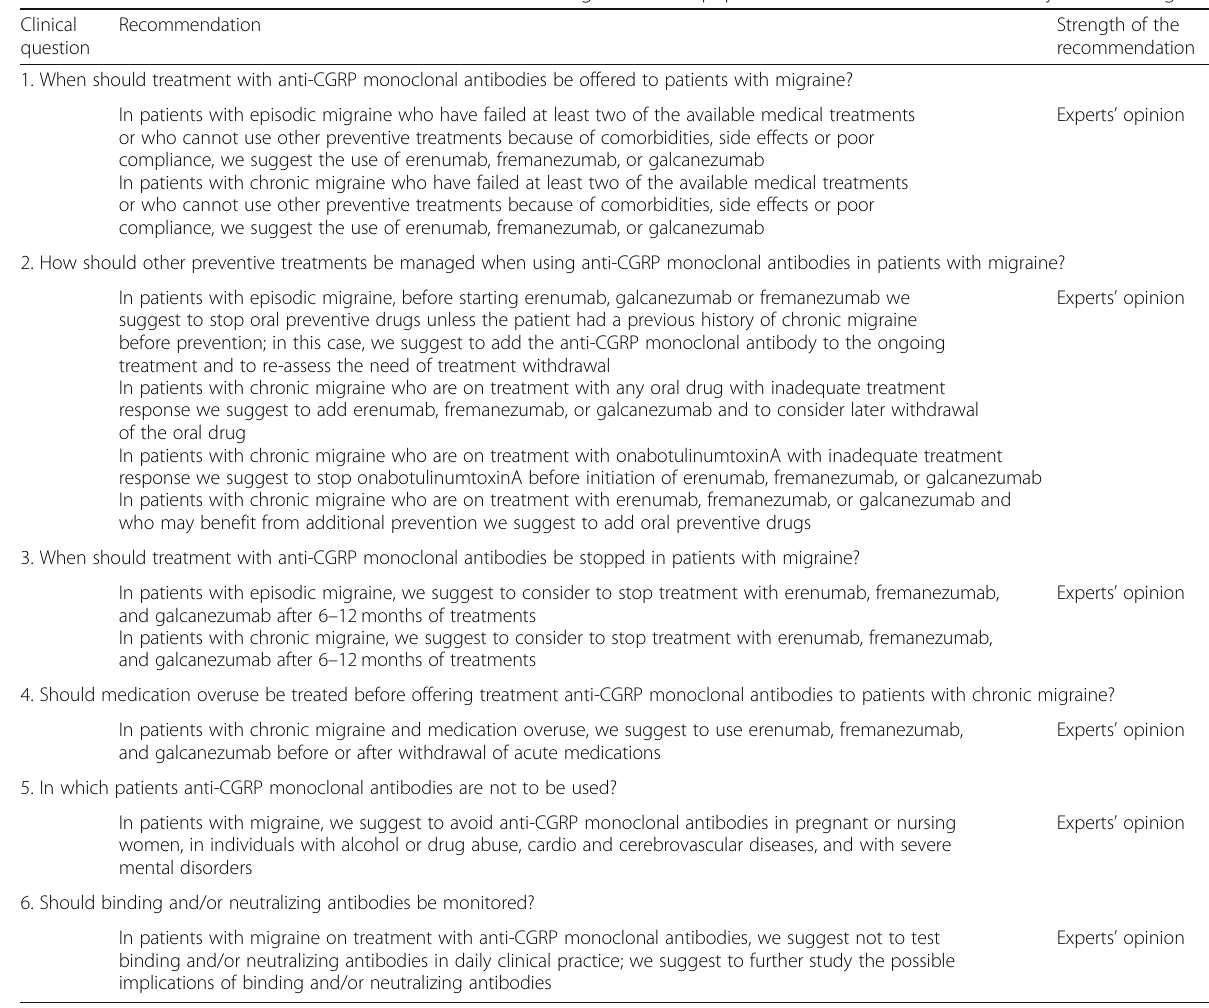
Table 19 Recommendations about the use of anti-calcitonin gene-related peptide monoclonal antibodies in subjects with